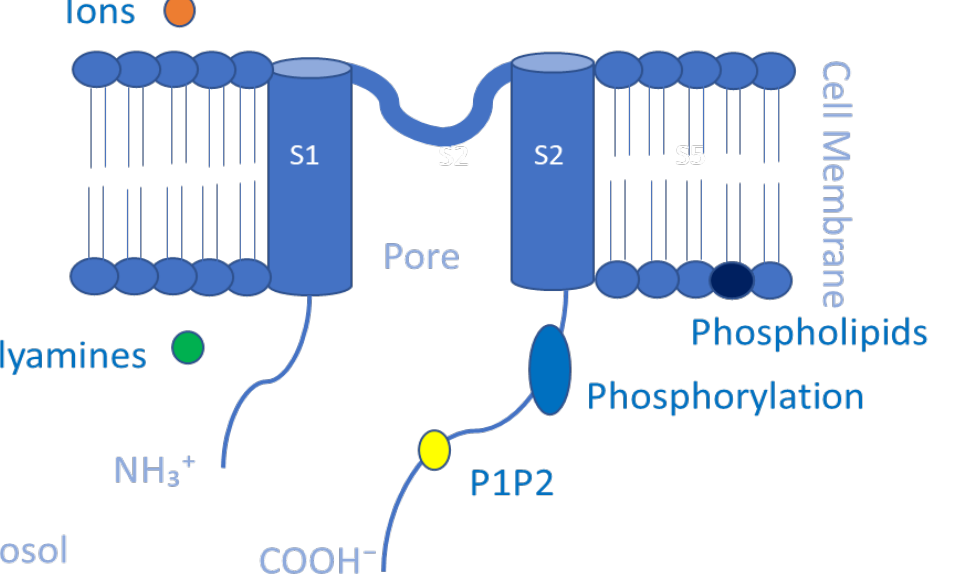
Figure 4. Schematic representation of the transmembrane (TM) topology of Kir channel subunits containing two TM segments with pores formed by S1 and S2. The functions of Kir channels can be regulated by small substances. The small substances are ions such as H + , Mg 2+ , and Na + ions (in orange); polyamines (in green); phosphatidylinositol 4,5-bisphosphate (PIP2) (in yellow); phosphorylation (in blue); membrane-bound phospholipids (in black).